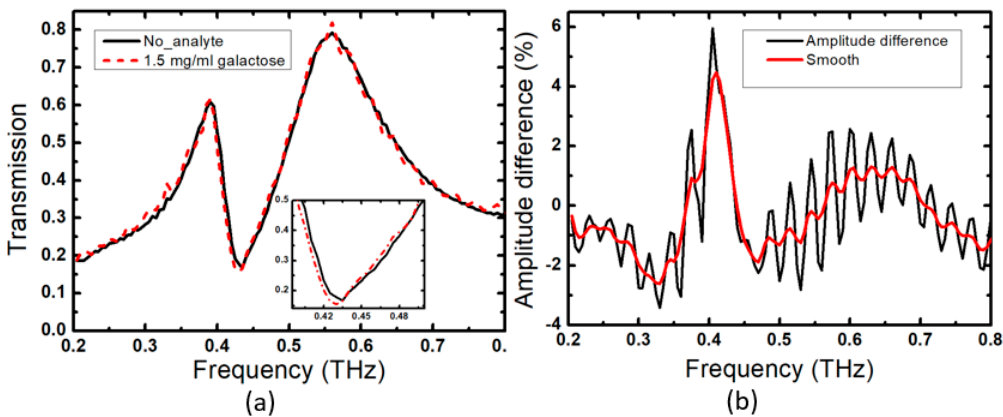
Figure 7. ( a ) Measured amplitude transmission spectra when galactose with concentration of 1.5 mg/mL is deposited on the sensor; the inset shows the response around 0.4 THz; ( b ) The amplitude difference percentage using the ADRT